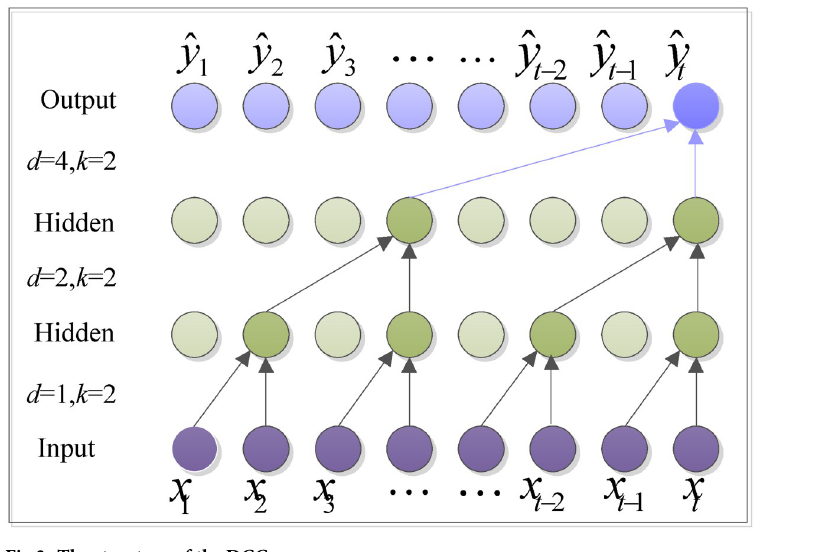
Fig 3. The structure of the DCC.